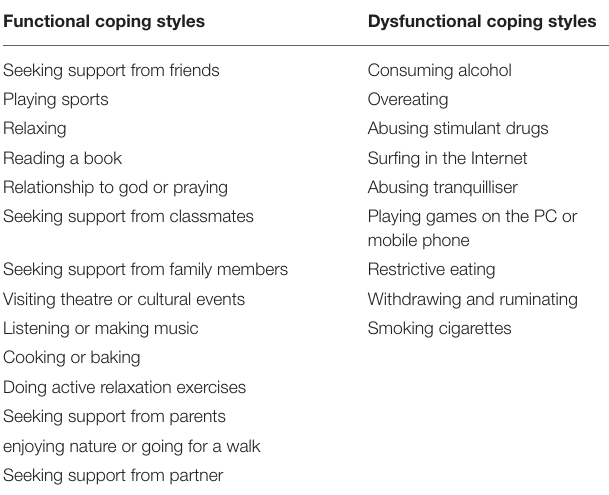
TABLE 1 | List of behavior-based functional and dysfunctional coping styles. Functional coping